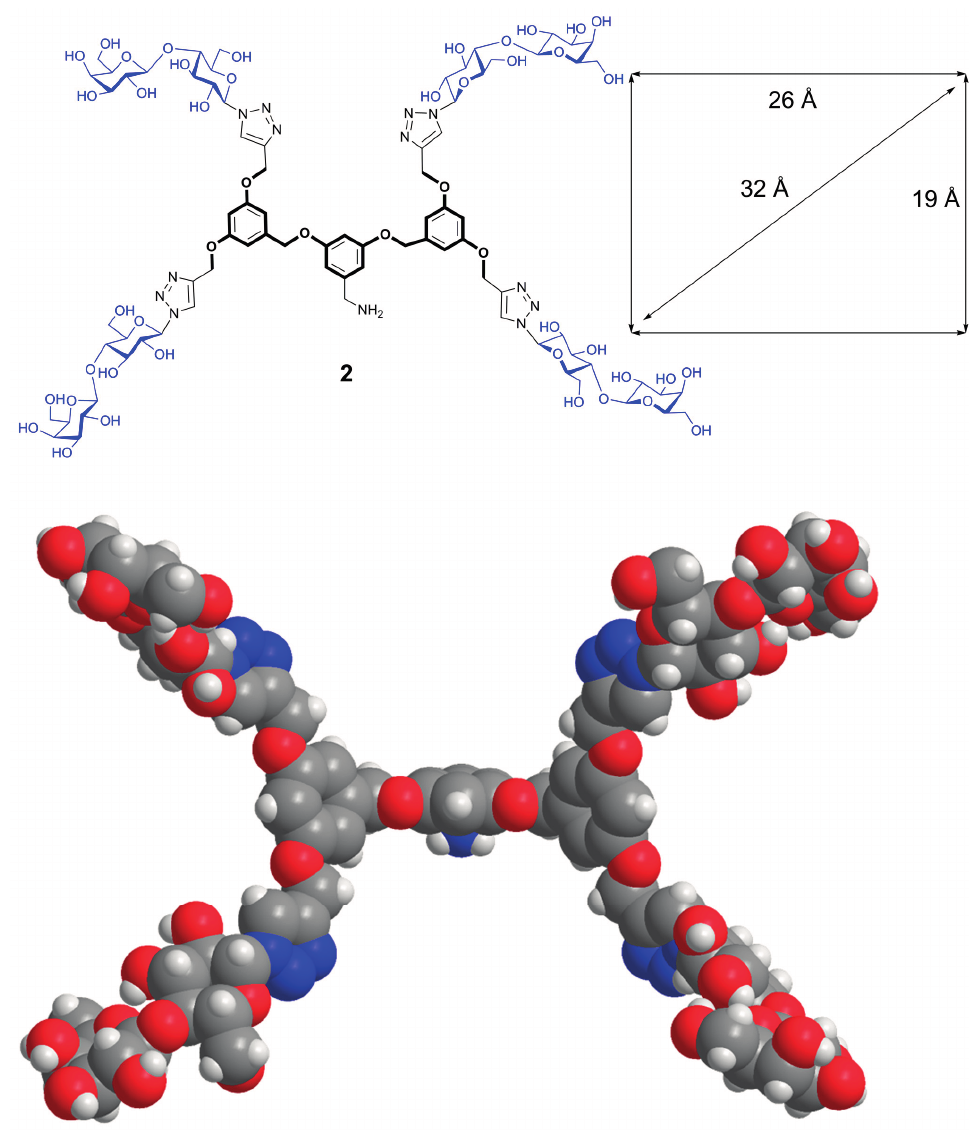
Figure 13. Computer-based estimation of the distance profile between branch ends of the tetravalent glycocluster 2 based on a 1,3-bis(3,5-dimethoxybenzyloxy)benzene core (for synthetic route, please see Scheme 1). The rectangular arrangement accounts for approximate distances of 19, 26 and 32 Å. For a conformer with tetrahedral arrangement of branch ends, please see Figure